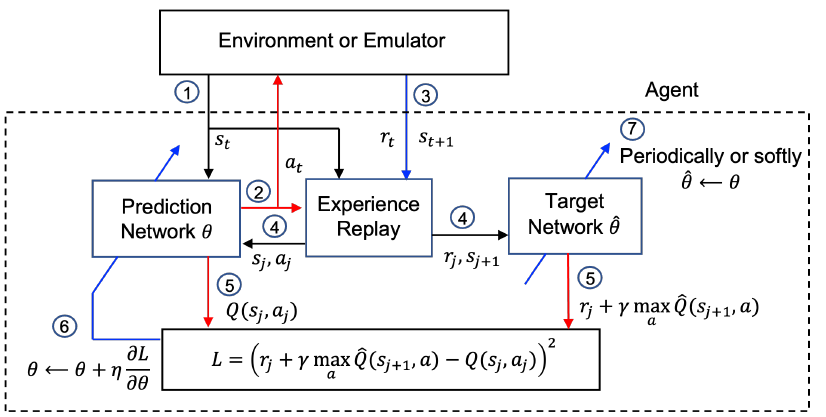
Figure 2. Summary of one learning iteration in the training phase of DQN, where the circled numbers denote orders of the learning